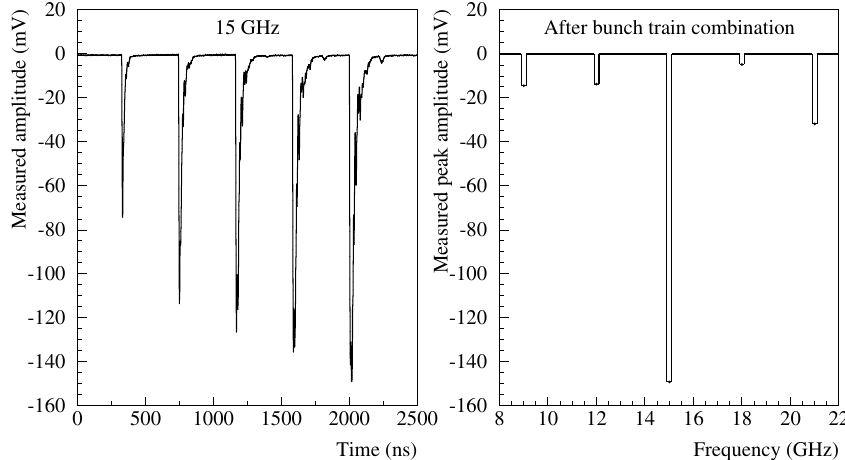
FIG. 28. Bunch frequency monitor signals at 15 GHz, while a bunch train combination with a factor 5 occurs (left panel) and amplitude of the five harmonics of interest measured on the oscilloscope at the end of the bunch frequency multiplication (right